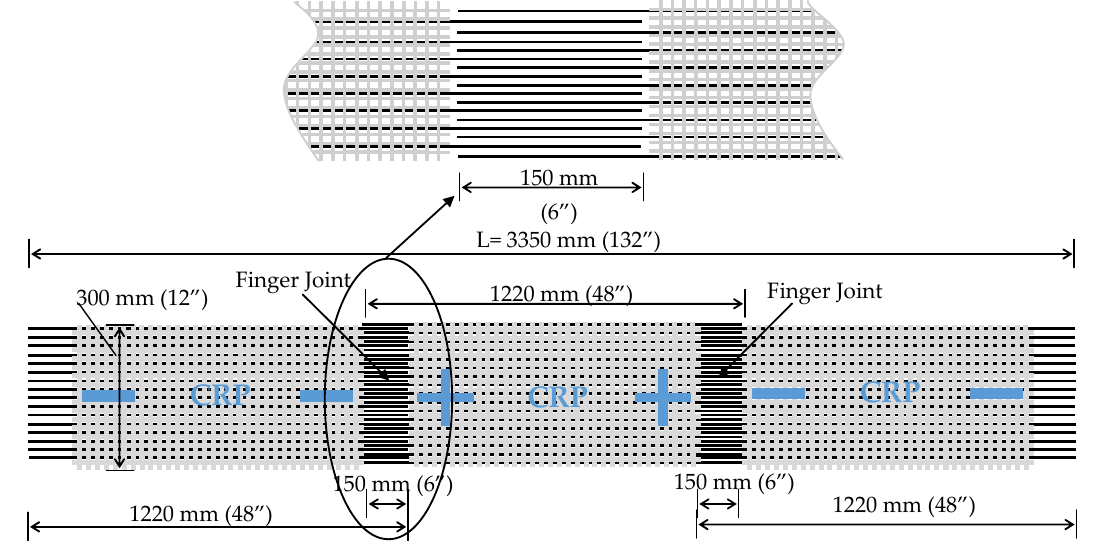
Table 1. CFRP Rod Panel (CRP) properties for two different rod sizes.